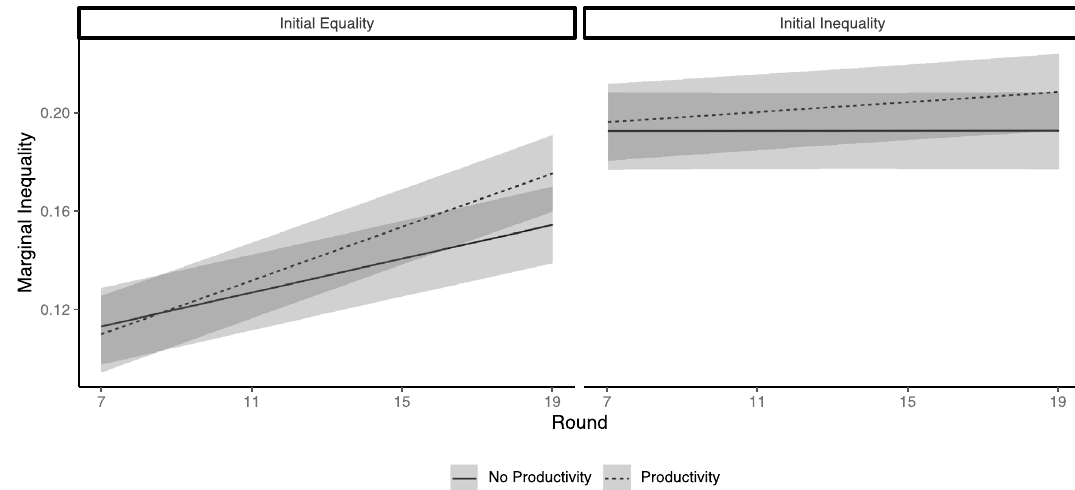
Figure 9. Marginal Inequality depicting the interaction between round, initial baseline endowment inequality, and wealth